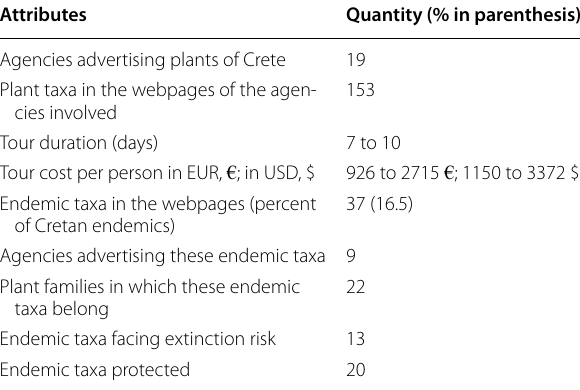
Table 3 Summary results regarding the quantitative aspects of wildlife tourism focusing on the Cretan